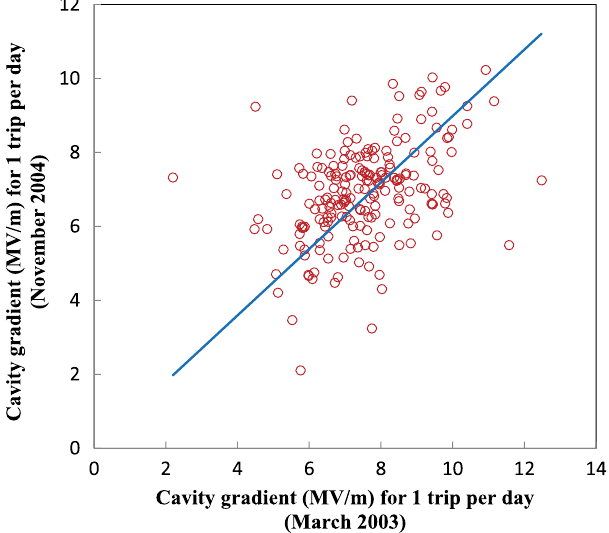
FIG. 18. Comparison of fixed arc-rate gradient conditions before and after the hurricane-induced thermal cycle and recovery (from